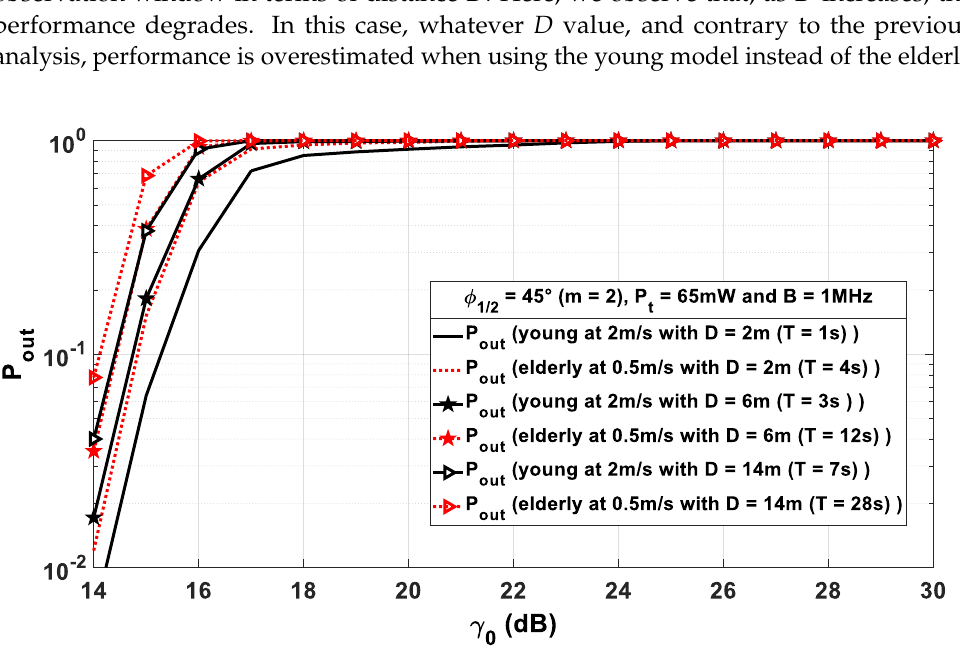
Figure 13. Outage probability P out as a function of γ 0 for different window sizes in terms of distance duration D .